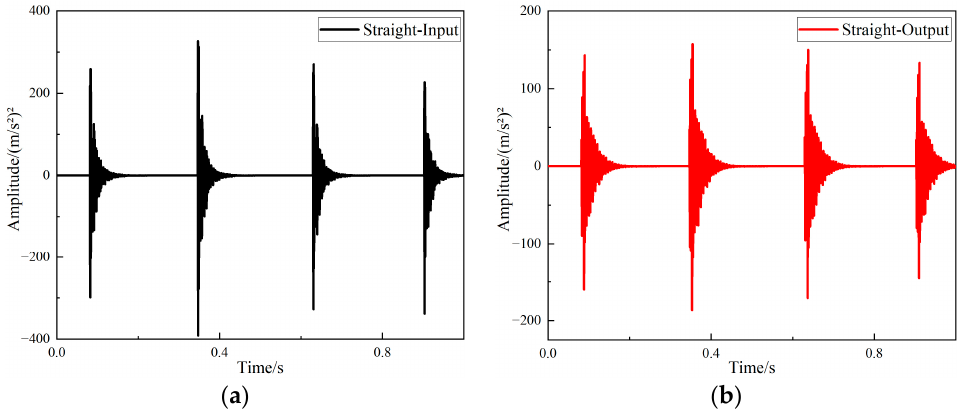
Figure 14. The response curves of the straight-tube structure support ( a ) Time domain input signal of straight-tube structure support, ( b ) time domain output signal of straight-tube structure support.